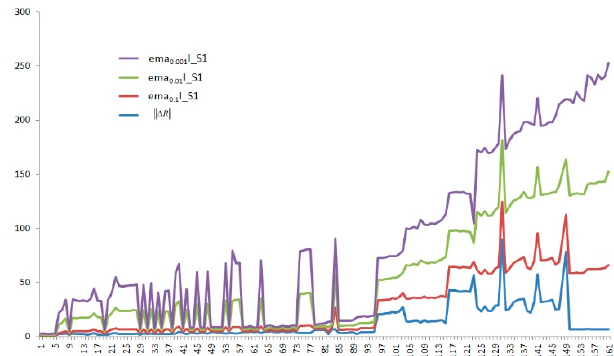
Figure 2. The results of the extraction feature.